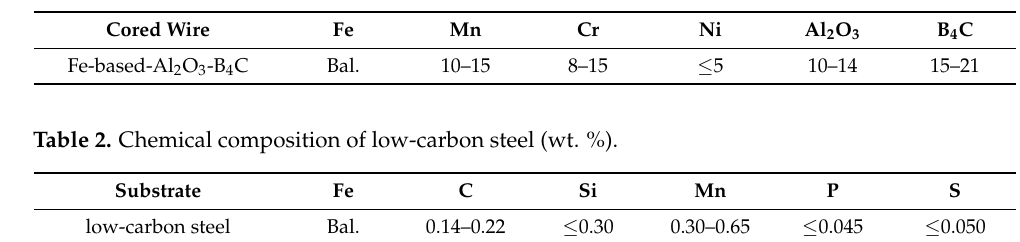
Table 1. Chemical composition of Fe-based-Al 2 O 3 -B 4 C cored wire (wt. %).